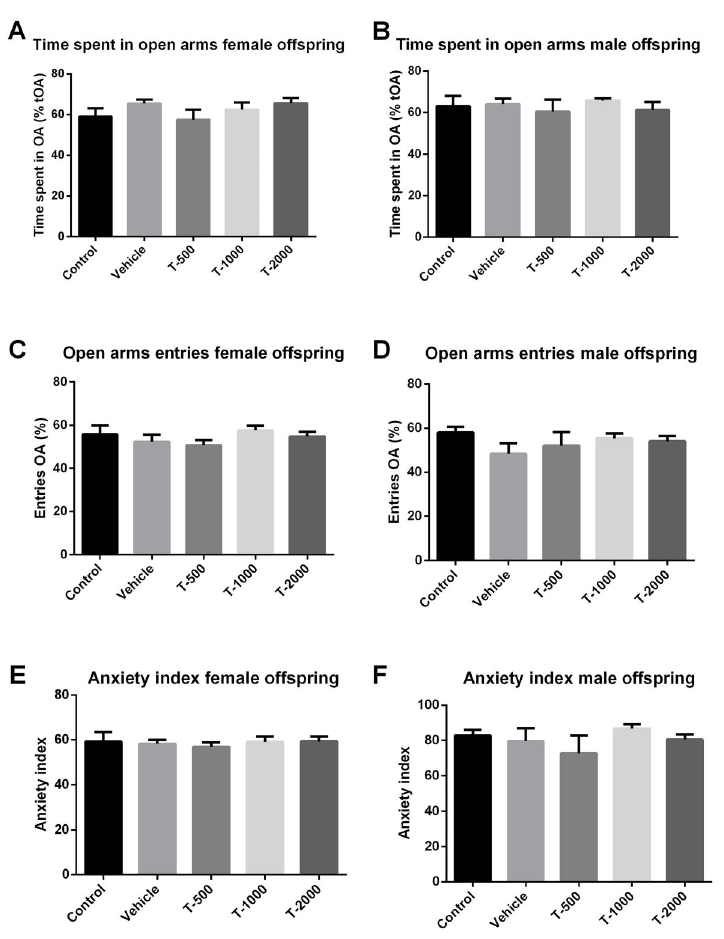
Figure 3. Anxiety-like behavior in adult offspring of mothers treated with valerian during the postpartum period. Groups: Control (1 mL distilled water), Vehicle (1 mL distilled water, 20% of glycerol), T-500 (500 mg (cid:1) kg – 1 (cid:1) day – 1 of valerian), T-1000 (1000 mg (cid:1) kg – 1 (cid:1) day – 1 of valerian), and T-2000 (2000 mg (cid:1) kg – 1 (cid:1) day – 1 of valerian). A , C , and E , percentage of time spent in the open arms (F(2,072, 18,65)=1.579, P=0.2325), percentage of number of entries (F(4, 53)=0.6700, P=0.4672), and anxiety index (F(4, 50)=1.357, P=0.9670) of female offspring. B , D , and F percentage of time spent in the open arms (F(2.031, 18.28)=0.2641, P=0.7740), percentage of number of entries (F(4, 48)=1.963, 0.4912), and anxiety index (F(4, 41)=0.9466, P=0.6230) of male offspring. Data are reported as means ± SE. (n=8 – 13 per group). Values in the groups were normalized to those in the control group. One-way ANOVA and Dunnett ’ s